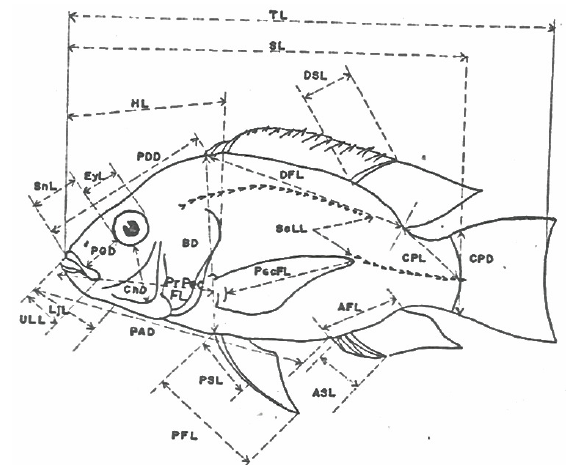
Fig. 2. Twenty five morphometric measurements as in Dunz and Schliewen